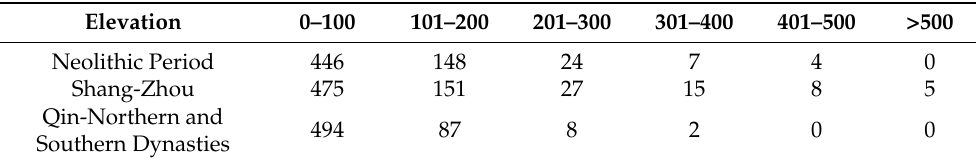
Figure 8. Relationship between settlement distribution and buffer zones in different periods. Table 2. Elevation distribution of settlements in different periods.